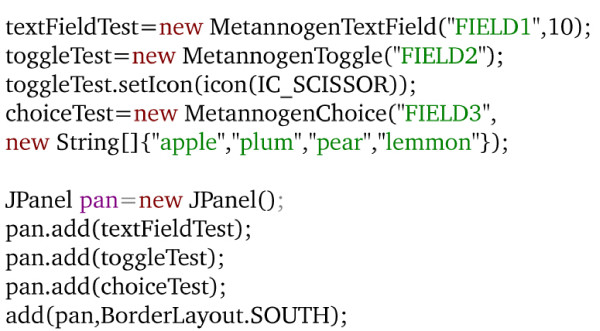
Code fragment exemplifying the extension of the graphical input form by three additional GUI elements. It exemplifies a text-field, a toggle button and a choice menu. The three components are placed in one JPanel which is added to the south.